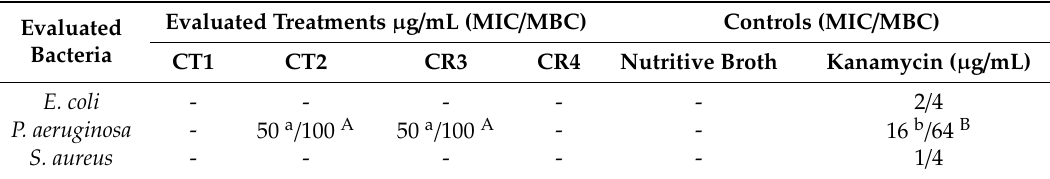
Table 2. Minimal Inhibitory Concentration (MIC) and Minimal Bactericidal Concentration (MBC) of Crotalus triseriatus and Crotalus ravus venoms .